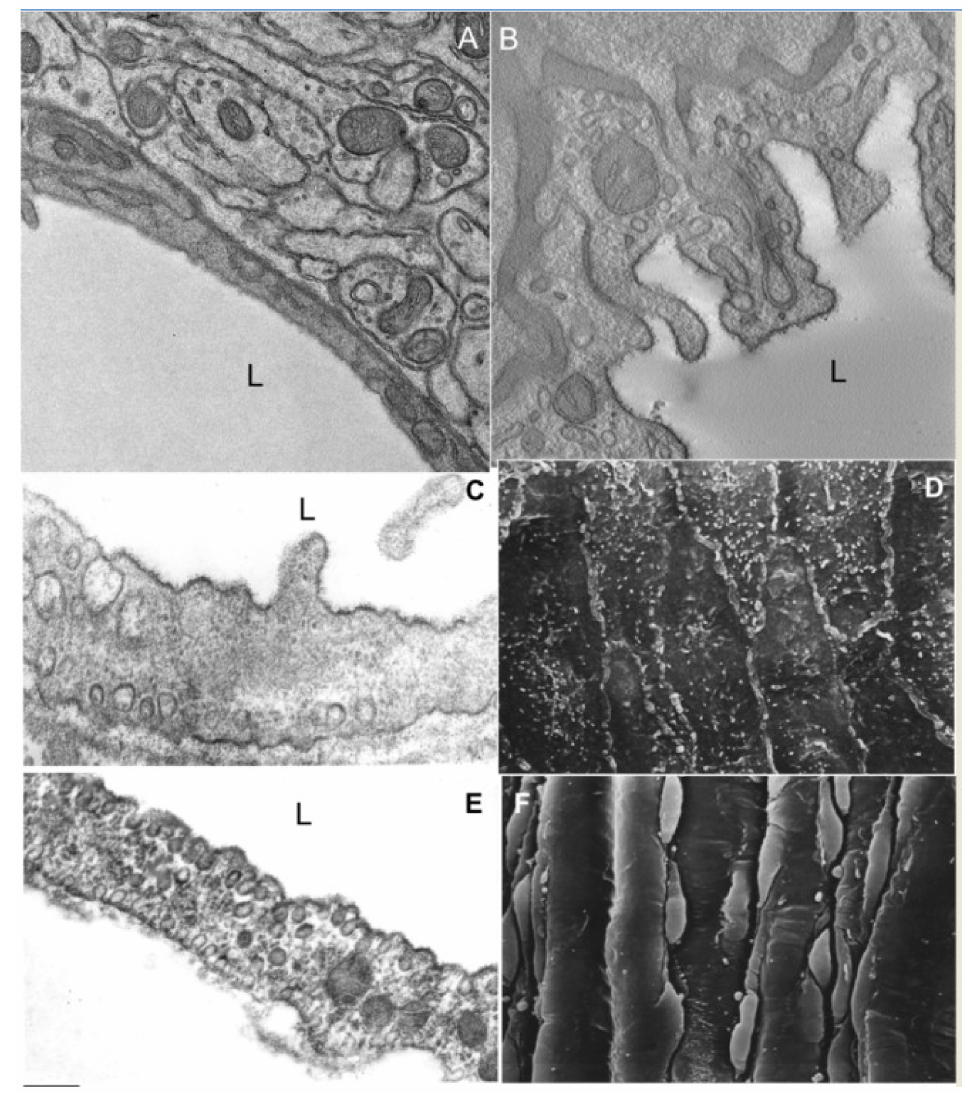
Figure 6. Caveolae and membrane geometry ( A ). ( B ) Low number of caveolae in an endothelial cell (EC) of the brain blood capillary. ( A ) Routine EM section. ( B ) Tomography virtual section. There are almost no caveolae. ( C ) Routine EM section of endothelial a cell of rat aorta after perfusion fixation. ( D ) Scanning EM (SEM) of the surface of endothelial cells (ECs) of rat aorta after perfusion fixation. The number of caveolae is low. ( E ) Routine longitudinal EM section of the aorta EC after immersion fixation. Many caveolae and their derivates are visible. ( F ) SEM of the rat aorta after immersion fixation. L-lumen of capillaries. Bars: 290 nm ( A ); 280 nm ( B , C , E ); 3 µ m ( D , F